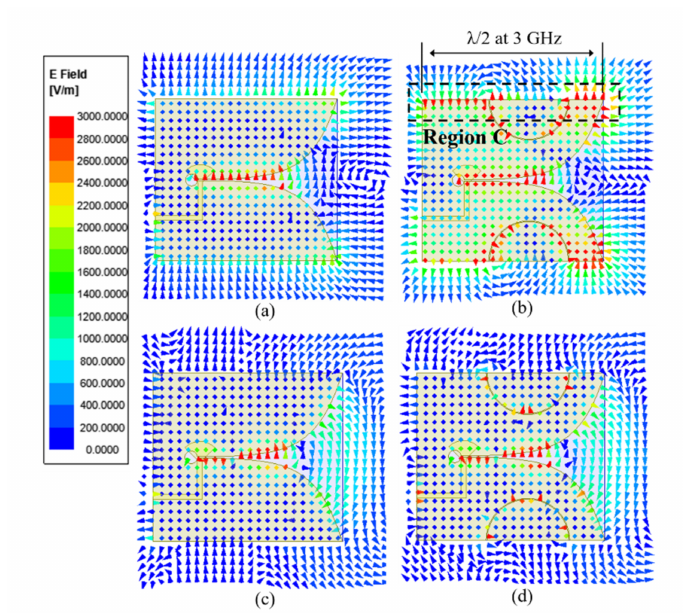
Figure 3. E-field distributions of the conventional Vivaldi antenna and SPEVA at ( a , b ) 3 GHz and ( c , d ) 7 GHz.